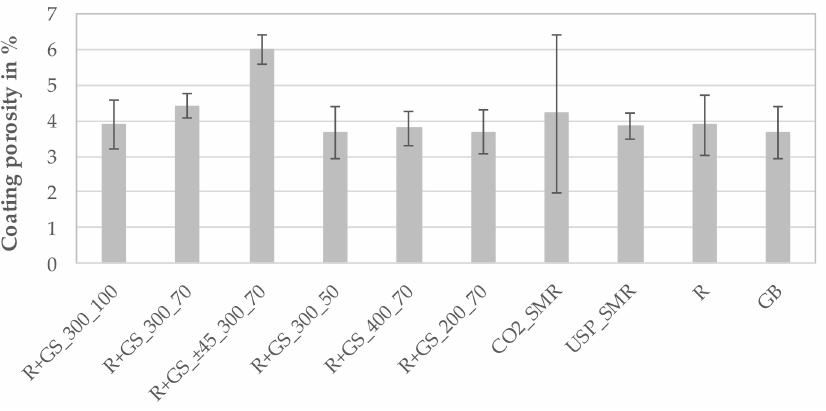
Figure 7. Porosity of wire arc sprayed copper coatings on laser-structured CFRP.